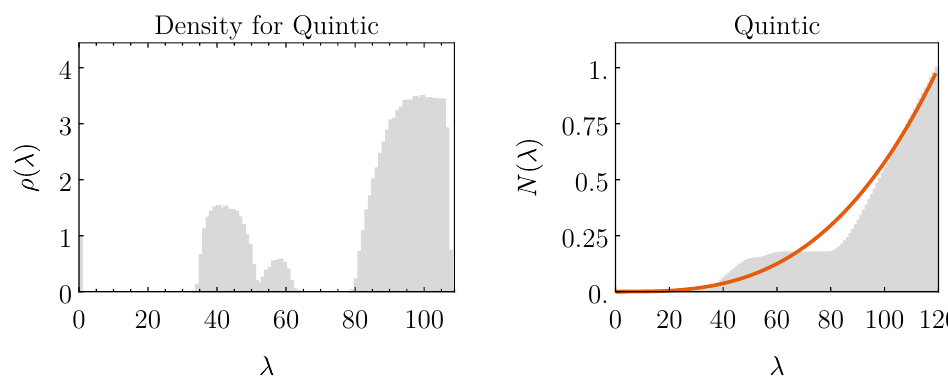
Figure 7 . On the left, we show the eigenvalue density for the Laplacian on quintic Calabi-Yau threefolds drawn from an ensemble of 1,000 samples in complex structure moduli space with each sample containing the lowest-lying 100 eigenvalues. On the right, we show the integrated eigenvalue density up to λ = 120 together with the asymptotic number of eigenvalues predicted by Weyl’s law (4.6) in orange — note that to more easily see the Weyl’s law behavior, we have used the lowest-lying 200 eigenvalues in this